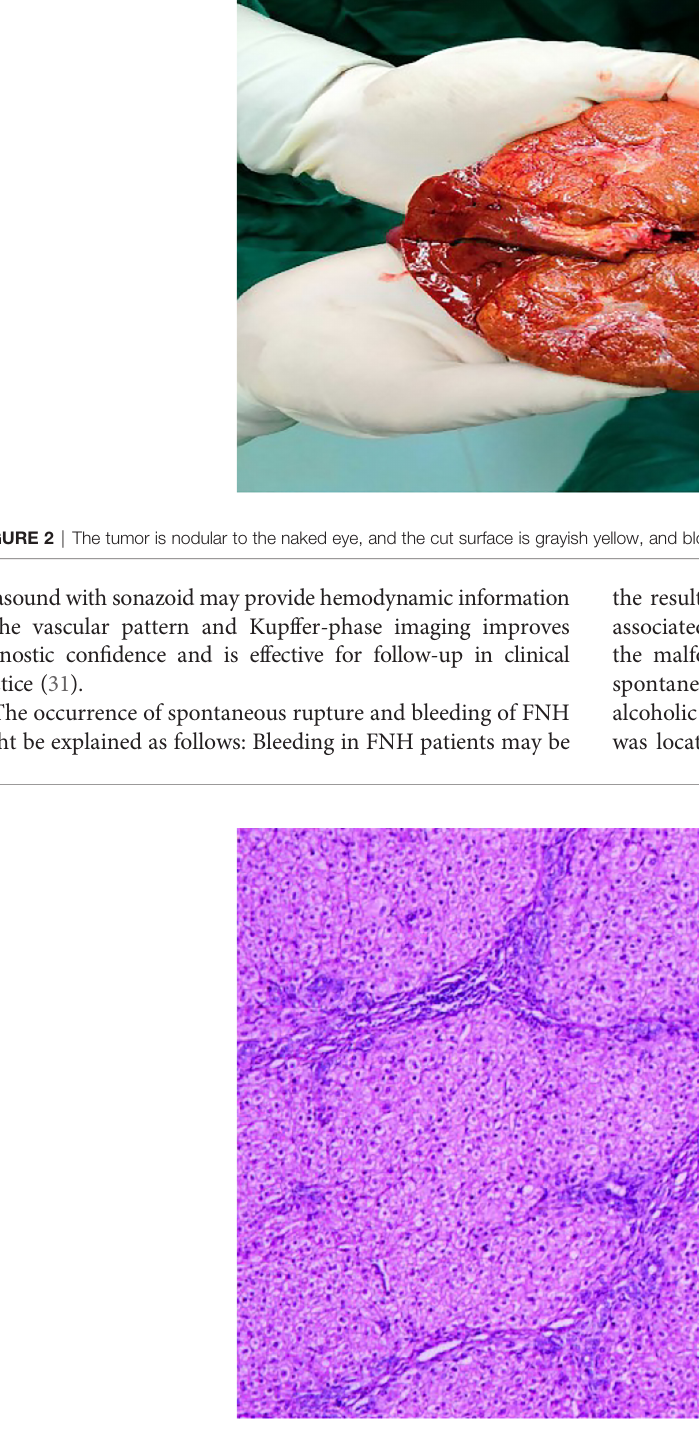
FIGURE 3 | Hematoxylin-eosin staining showed hepatocyte proliferation and vasodilation, and no atypical cells.